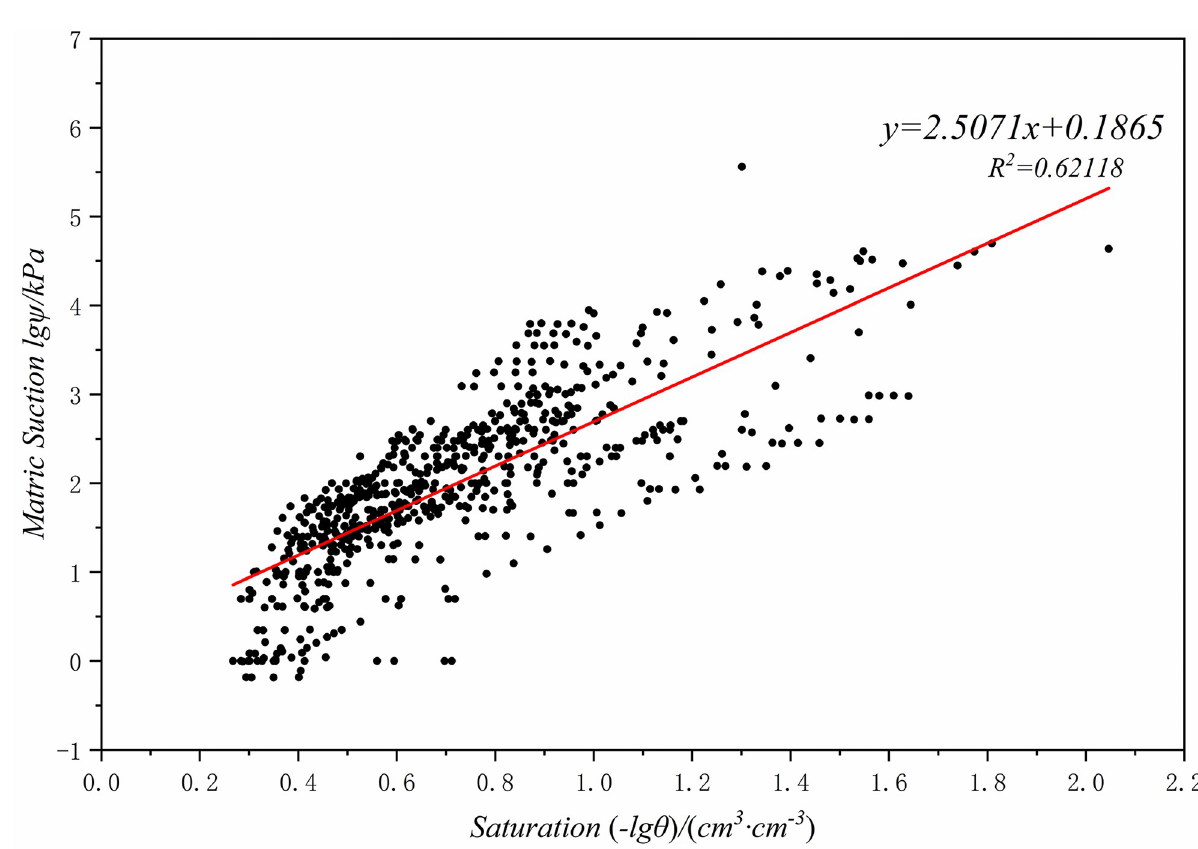
Fig 8. Typical loess (Zone II) degree of saturation and matric suction fitting result.